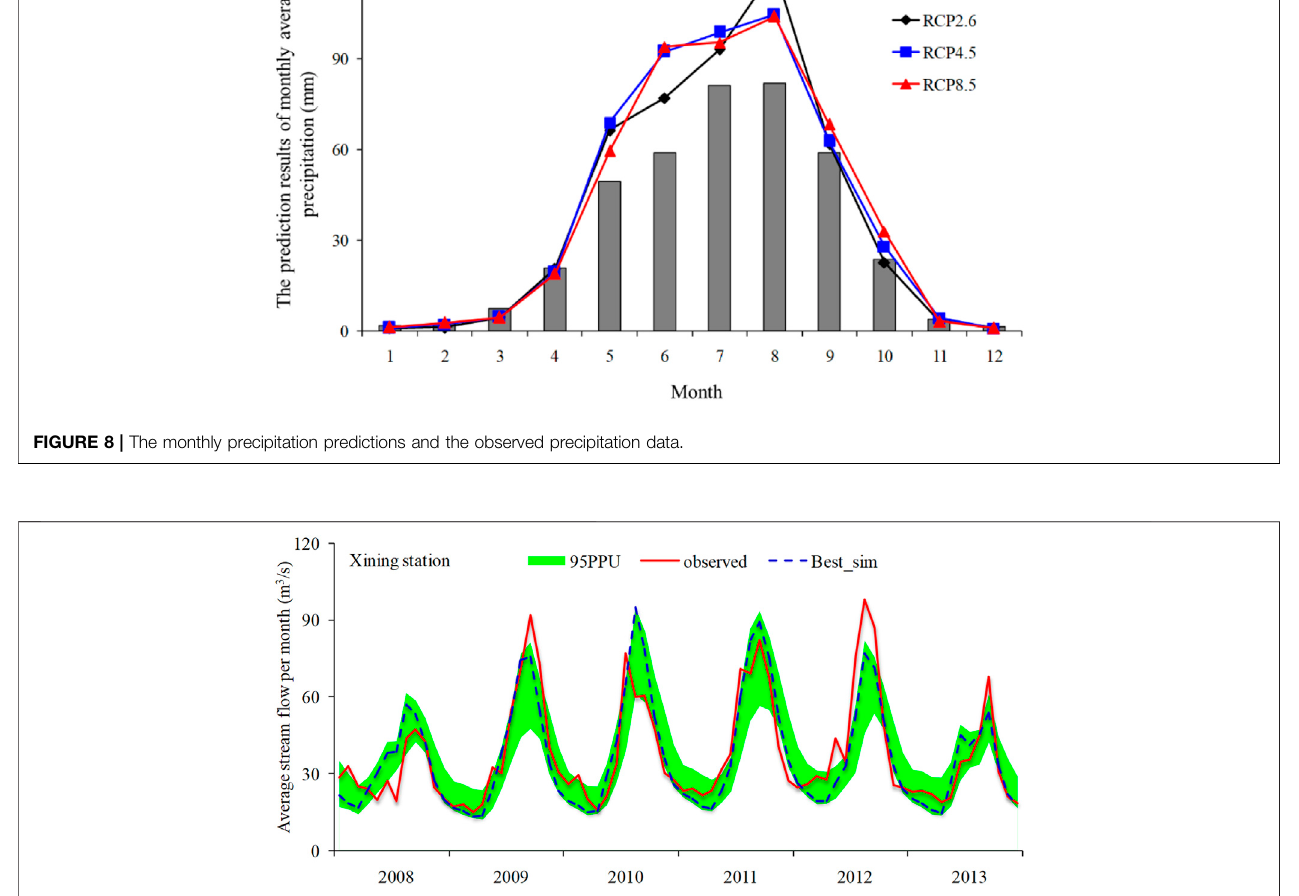
FIGURE 9 | The observed results of the calibration period, optimum simulation results, and 95% con fi dence interval.